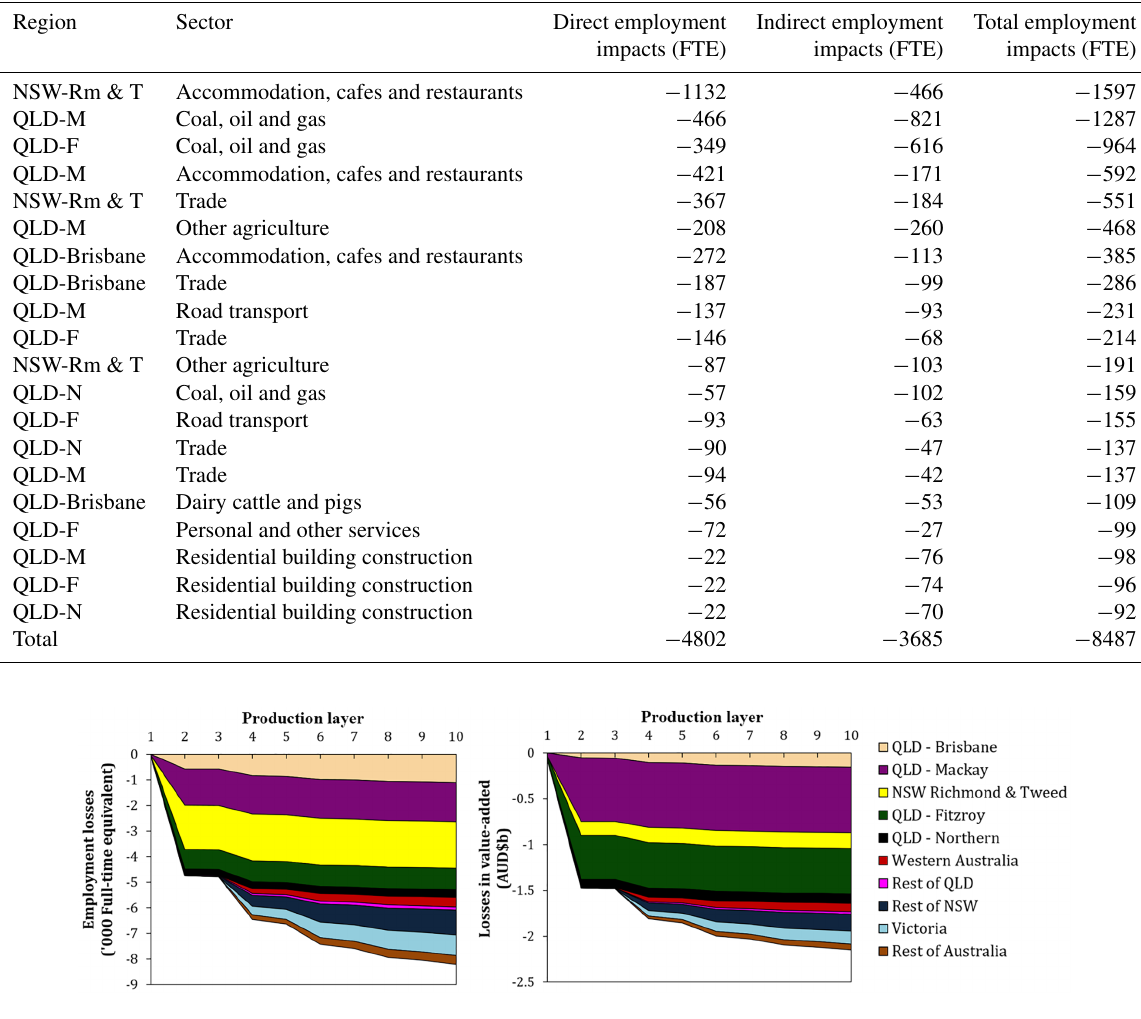
Figure 2. Total losses in value added and employment resulting from Tropical Cyclone Debbie for various regions across a number of upstream production layers. The figure shows the first 10 production layers, which are upstream layers of the supply chain (see Sect. S3 for underlying